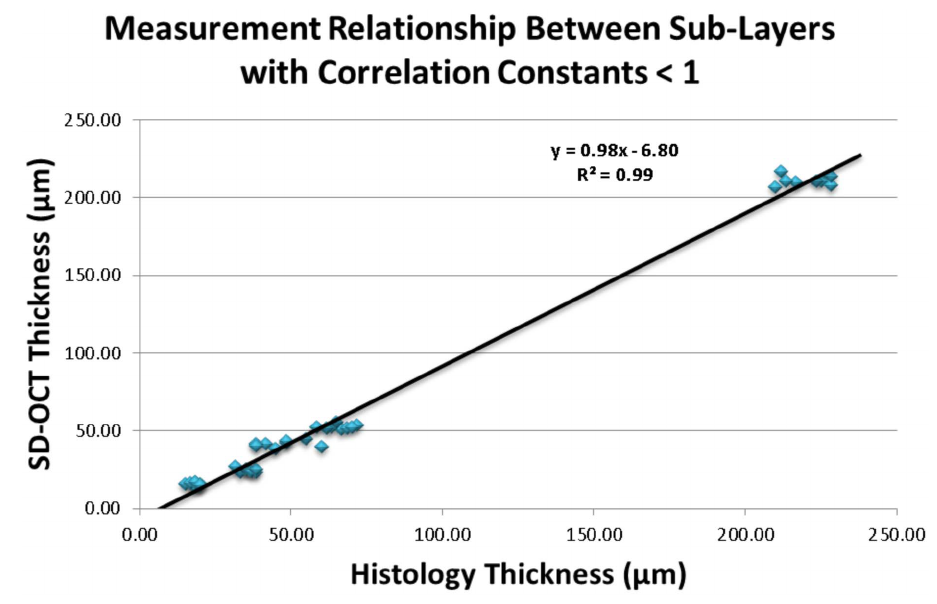
Figure 4. Association between mean SD-OCT and histological thickness with correlation constants , 1. Scatter plot points refer to all observations for outer segment/inner segment/external limiting membrane, outer plexiform layer, inner nuclear layer, inner plexiform/ganglion cell layers, and total retinal thickness.